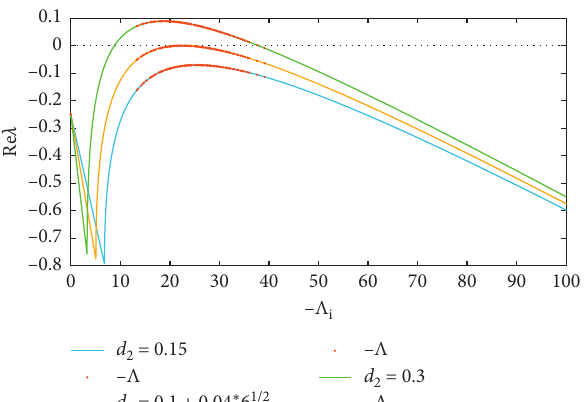
Figure 4: Linear stability analysis. The relationship graph between Re λ about Λ values are Λ c � − (( 2 +